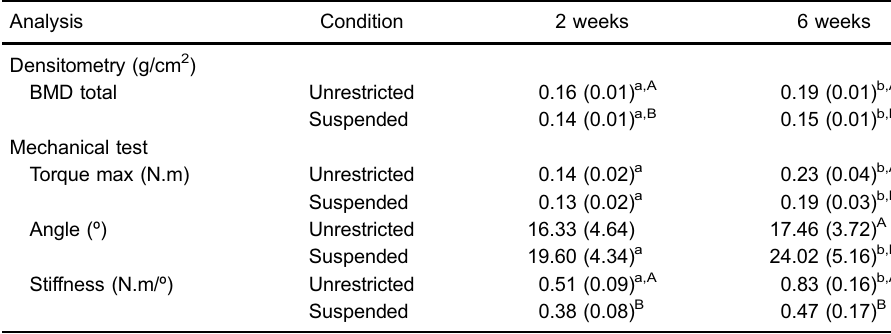
Table 3. Analyses of the left tibia (internal